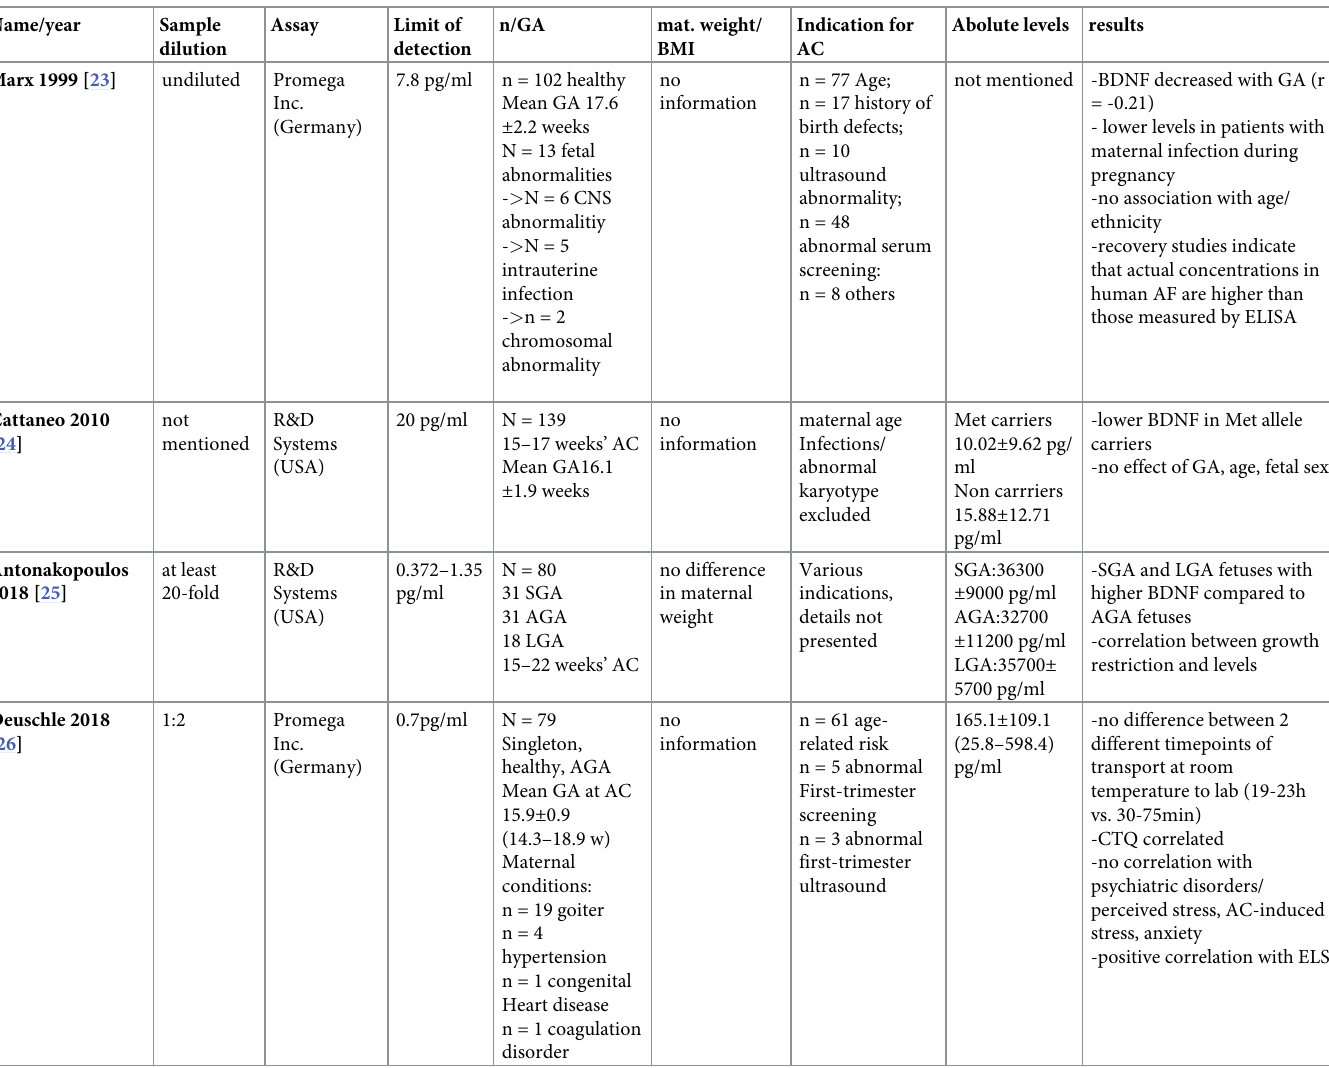
Table 2. Literature on BDNF in human amniotic